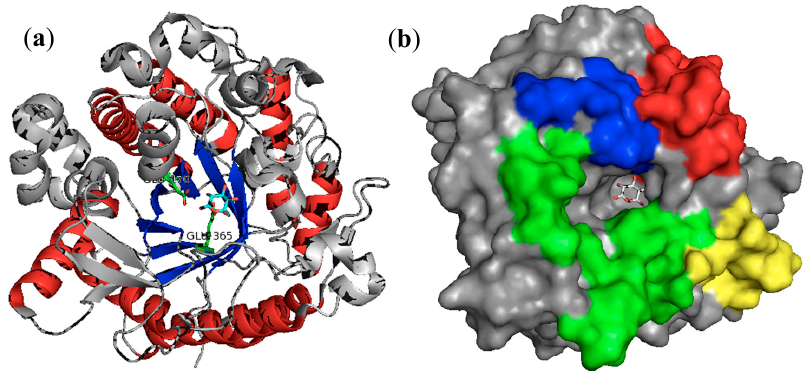
Figure 2. Structure of GH1 β -glucosidase complexed with gluconolactone. ( a ) Ribbon representation of the ( α / β ) 8 -TIM barrel structure and active site. α -Helices are shown in red and β -sheet in blue. Glu170 and Glu165 are represented by green lines; ( b ) Molecular surface with representation of four loops on the entrance of active site. Loops A, B, C and D are shown in red, blue, green and yellow, respectively. The 3D structure was obtained from the Protein Data Bank (PDB) using Pymol vs. 0.99. The PDB code is 2E40.